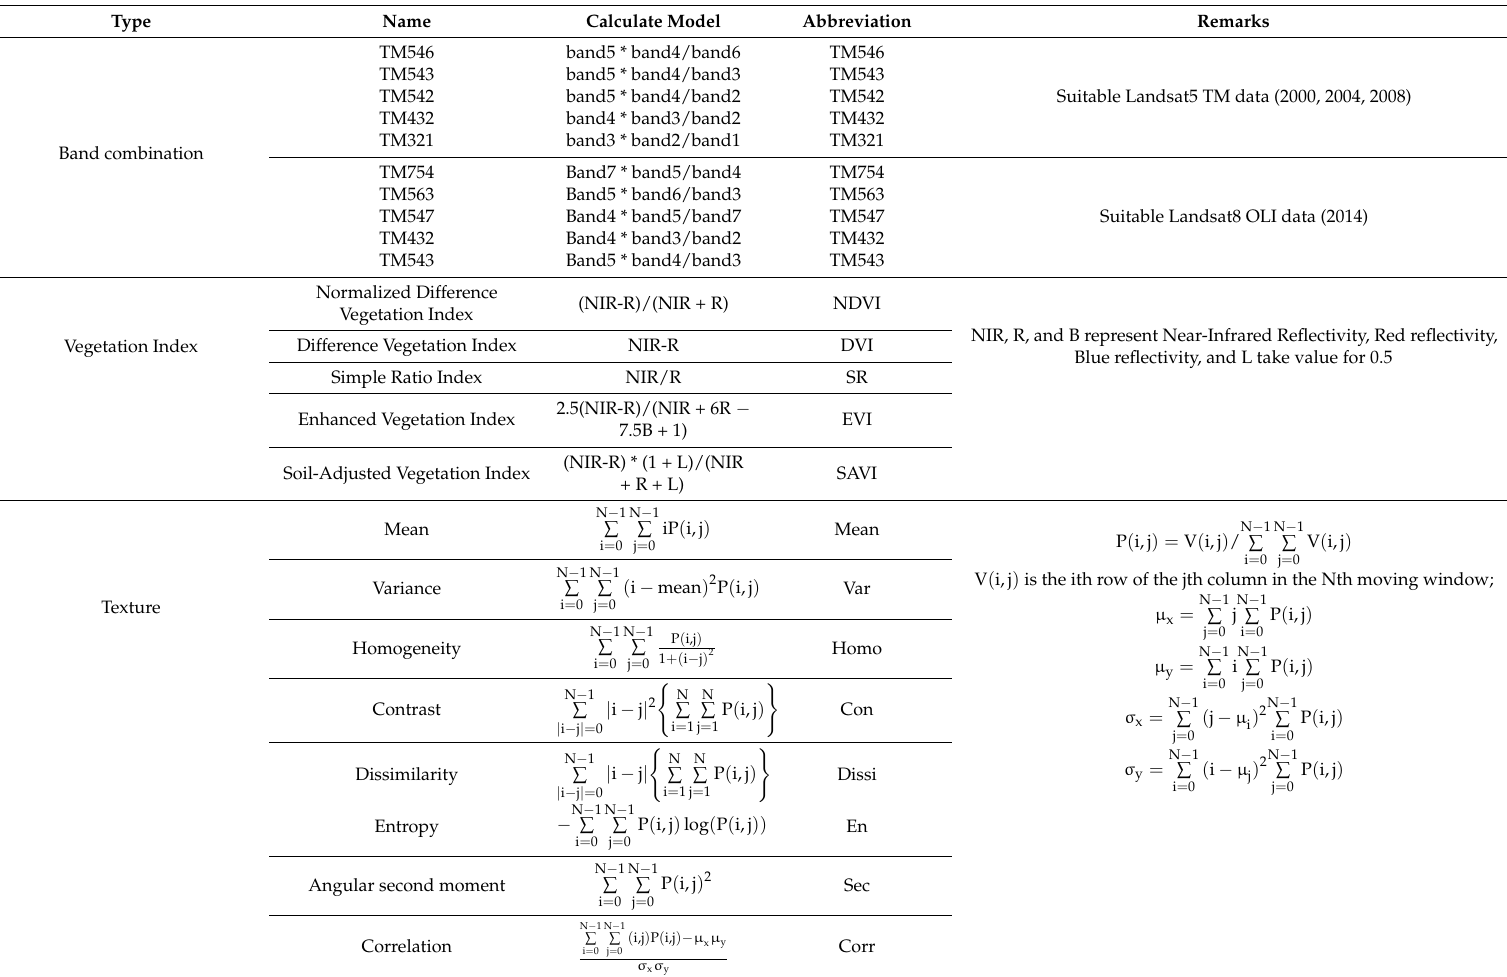
Table 1. Information of remote sensing